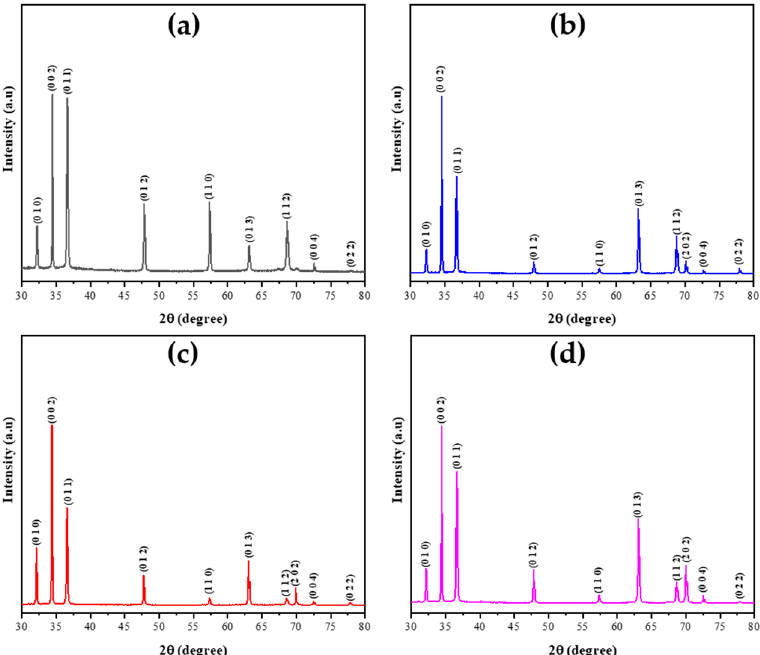
Figure 3. XRD analysis results of the samples: ( a ) pure Mg, ( b ) Mg ‐ 0.5Si 3 N 4 , ( c ) Mg ‐ 1.0Si 3 N 4 , and ( d ) Mg ‐ 1.5Si 3 N 4 .